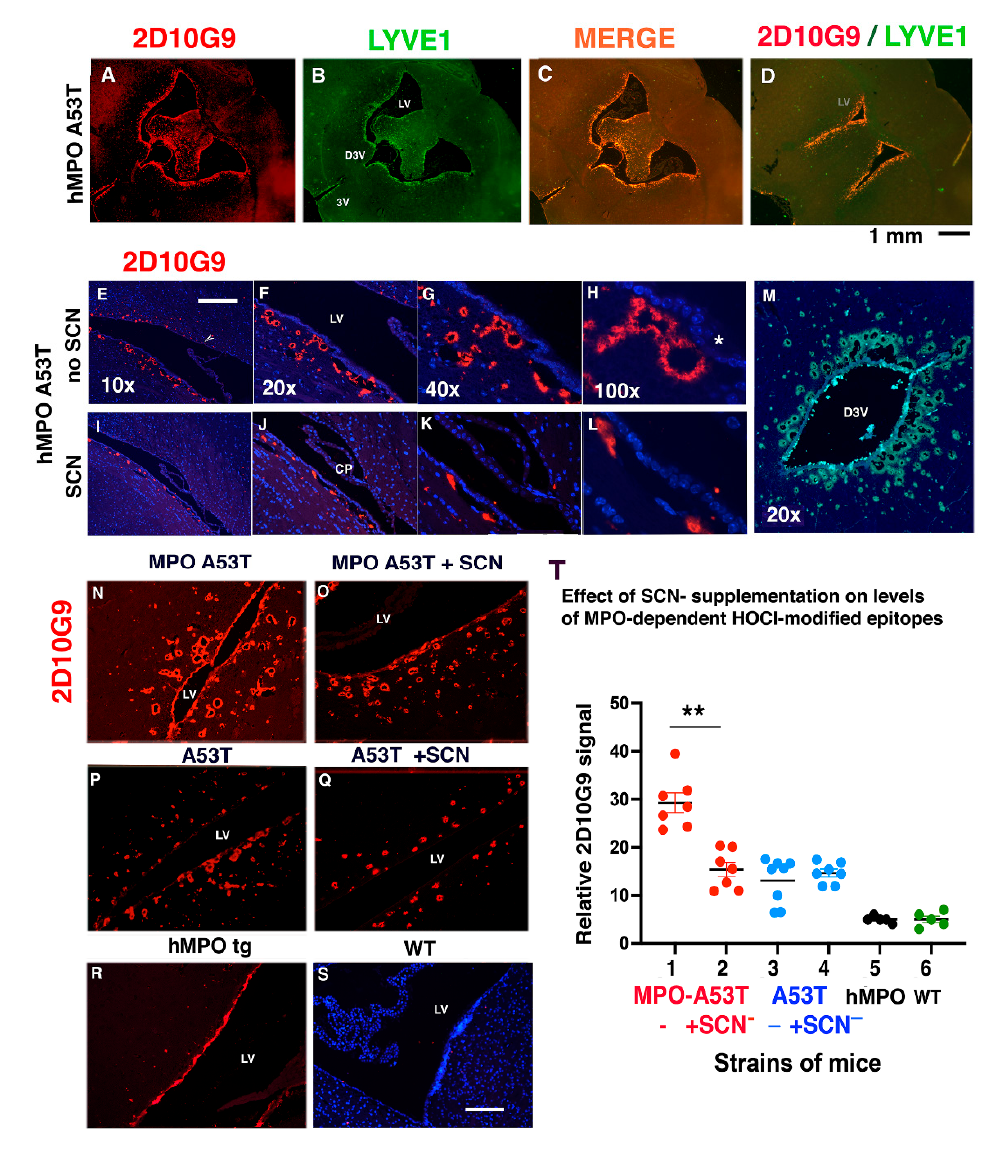
Figure 3. Thiocyanate treatment reduces size and number of 2D10G9 MPO modified HOCl epitopes in the MPO A53T mice but not in A53T lacking hMPO. ( A – D ) Coronal sections of hMPO-A53T brain show colocalization of MPO-generated HOCl epitopes (using 2D10G9) ( A ) and LYVE1 ( B ) with merged image in ( C ) and another merged image from a more anterior position ( D ). Panel ( B ) shows location of the lateral ventricles (LV), dorsal third ventricle (D3V) and third ventricle (3V). ( M ) 2D10G9 staining of numerous vessels surrounding the dorsal third ventricle. Scale bar ( A – D ) 1 mm. (E-H) 2D10G9 immunostaining of periventricular vessels in hMPO-A53T brain from mice that were not treated with SCN − . Images were made at 10× ( E ), 20× ( F ), 40×, ( G ), and 100× ( H ) objectives. Scale bar for E–L: E 0.1 mm. ( I – L ) Immunoreactivity of 2D10G9 in periventricular vessels in hMPO-A53T brain from mice that were treated with SCN − . Images were made at 10× ( E ), 20×, ( F ) 40× ( G ), and 100× (H) objectives. Choroid Plexus (CP, Panel ( J )). ( N – Q ) 2D10G9 immunofluorescence staining of hMPO-A53T lateral ventricle from mice not treated with SCN − ( N ), compared to hMPO-A53T mice treated with SCN − ( O ). D10 staining of A53T mice not treated with SCN − ( P ), compared to A53T treated with SCN − ( Q ). Controls show D10 staining of the lateral ventricle from MPO trans- genic mice lacking the A53T transgene ( R ) and WT mouse brain ( S ). Objective was 20×. Scale bar: (N-S) 0.1 mm. ( T ) 2D10G9 immunofluorescence staining was quantitated for the periventricular re- gions from hMPO-A53T and A53T brain with or without SCN − treatment. Lane 1 shows the relative 2D10G9 fluorescence signal in hMPO-A53T mice not treated with SCN − (n = 7). Lane 2 shows the signal for hMPO-A53T mice treated with SCN − (n = 7). Lane 3 shows the signal in A53T mice not treated with SCN − (n = 8). Lane 4 shows the signal in A53T mice treated with SCN − (n = 7). Little to